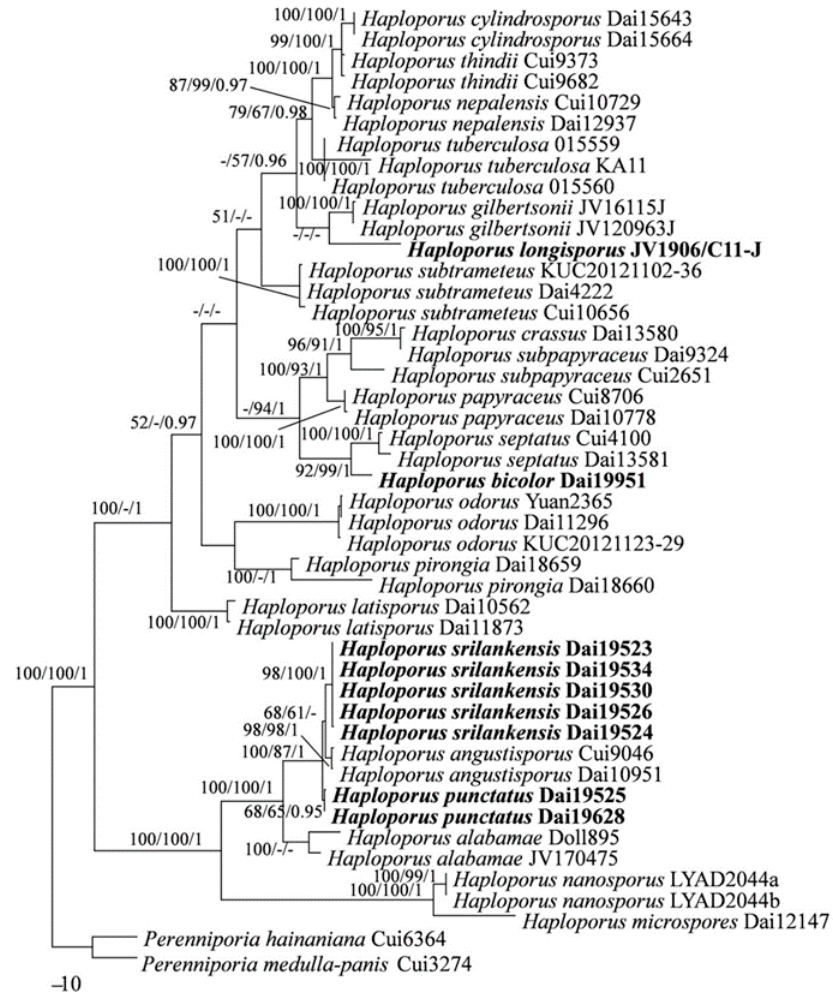
Figure 2. Maximum parsimony strict consensus tree illustrating the phylogeny of Haploporus based on ITS + nLSU + mtSSU sequences. Branches are labeled with parsimony bootstrap values ≥ 50% and Bayesian posterior probabilities ≥ 0.90.